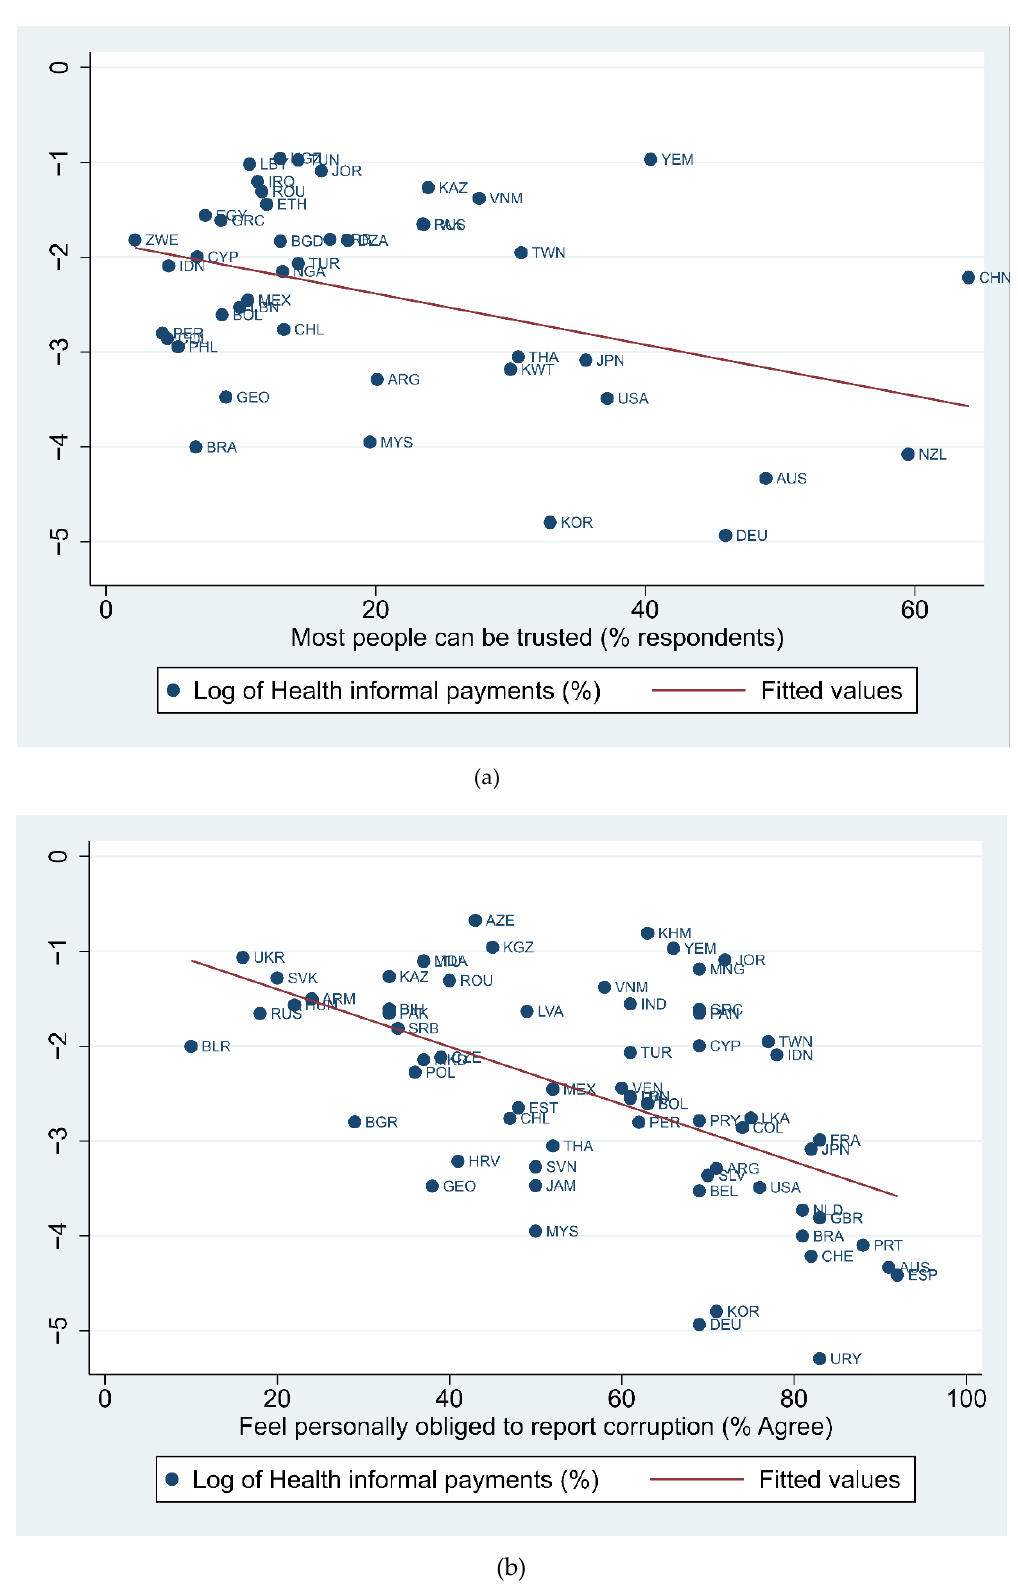
Figure A1. The relation between informal payments in health and informal institutions. ( a ) The relation between informal payments in health and social trust. Source : Authors’ representation using data from Transparency International and World Value Survey. ( b ) The relation between informal payments in health and the personal engagement in reporting corruption. Source : Authors’ representation using data from Transparency International.